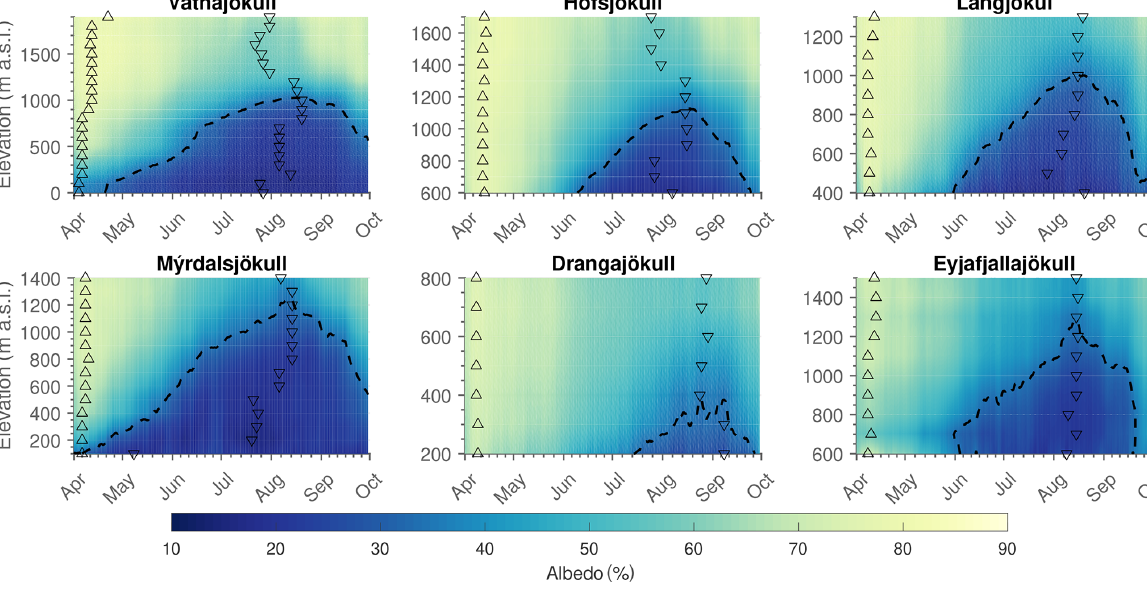
Figure 6. Albedo as a function of elevation and time for the period 2000–2019. Triangles show the max–min values associated with each elevation band, and the dotted black line shows the isoline for 34% albedo, as defined by Cuffey and Paterson (2010) for bare glacier ice.